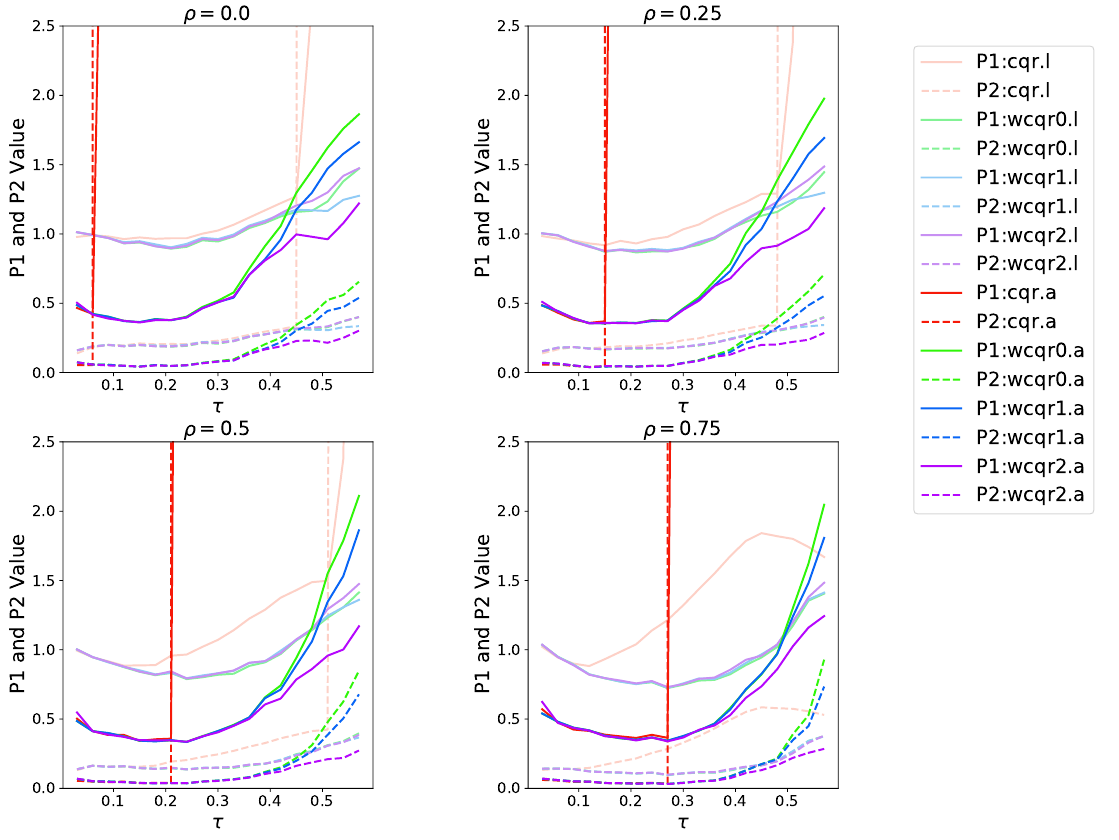
Figure 2. Case n = 200, s = 30, p 0 = 0.8, p 1 = 0.6. Comparison of P1 and P2 for four levels of ρ . In each subplot, the Y axis reports the P1 and P2 values at different τ . The solid line is P1 and the dashed line is P2. Four colors are used to represent the methods: red for cqr, green for wcqr0, blue for wcqr1, and purple for wcqr2. Light colors represent the LASSO penalty and dark colors are the ALASSO penalty for all